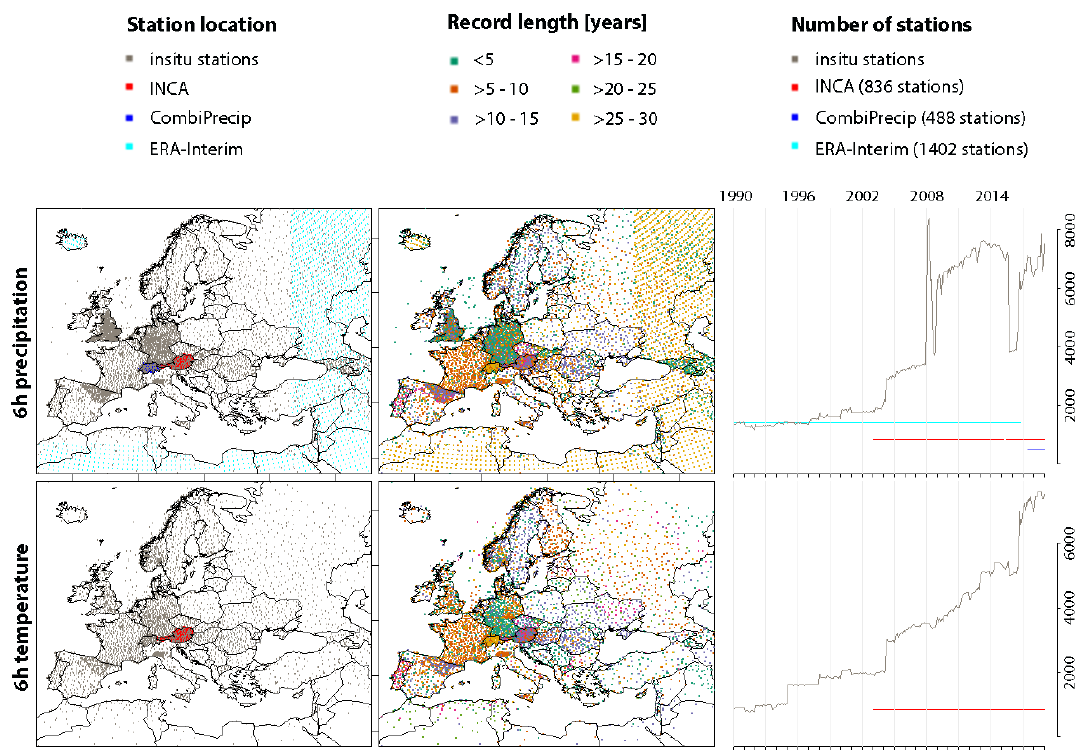
Figure 3. Input data for 6-hourly EMO-5 precipitation and temperature grids in terms of station locations, record lengths, and number of stations